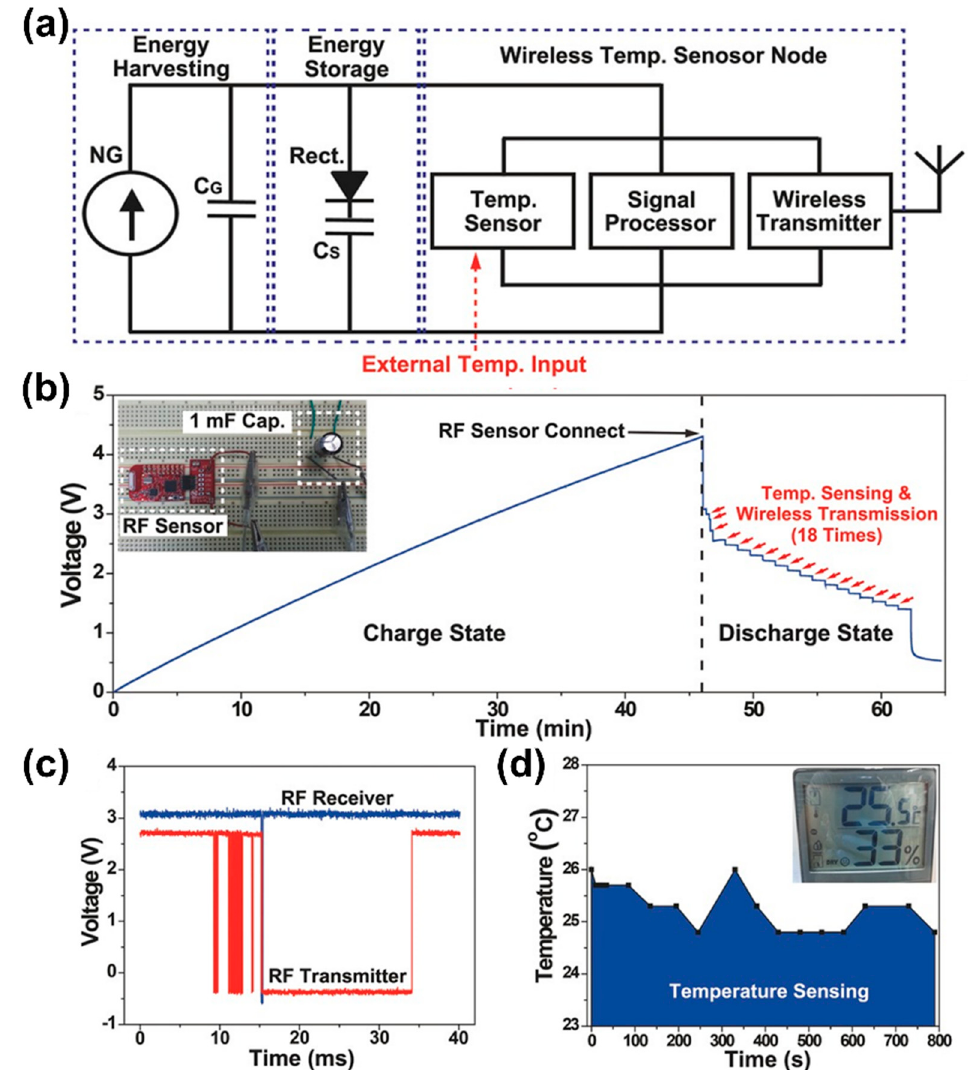
Figure 11. ( a ) Schematic circuit of self − powered temperature IoT system. ( b ) The charging and discharging response of a capacitor by PZT energy harvester for energy storage and operation of the temperature sensor node. ( c ) Output voltage measured from input/output pins of RF transmitter and receiver module. ( d ) The measured temperature was transmitted from the IoT system in 800 s. The digital thermometer shows the measured ambient temperature (inset). Reproduced with permission [119].